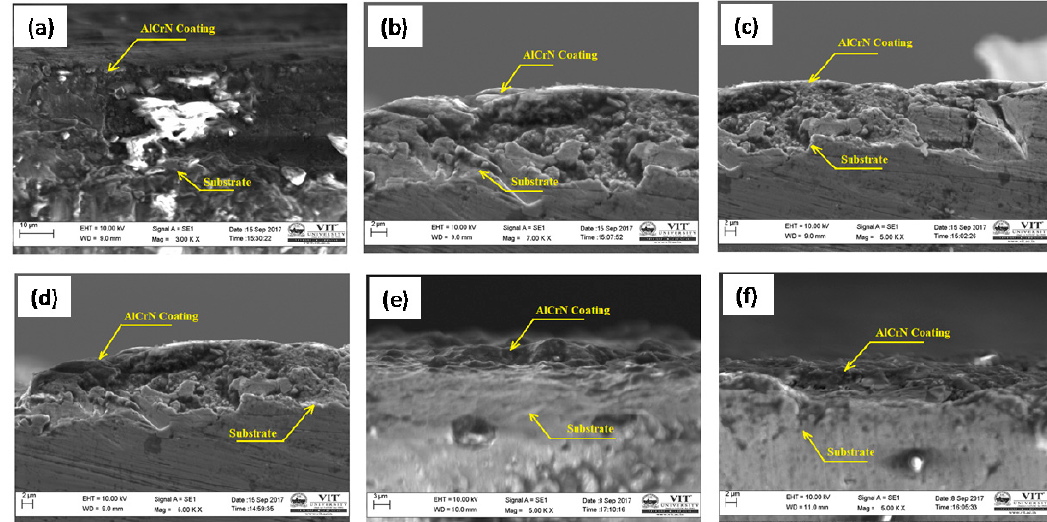
Figure 6. SEM images of cross sectional area of the monolayer coating ( a ) Fe, ( b ) Fe–2Cu, ( c ) Fe–2Cu–0.8C, ( d ) Fe–2Cu–0.8C–0.2Mo, ( e ) Fe–2Cu–0.8C–0.4Mo and ( f ) Fe–2Cu–0.8C–0.6Mo.